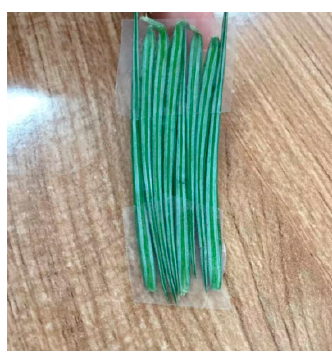
Figure A4. The vacuum side of one group of leaf leaves prepared for spectral measurement. Leaf samples were collected on 15 July 2016.